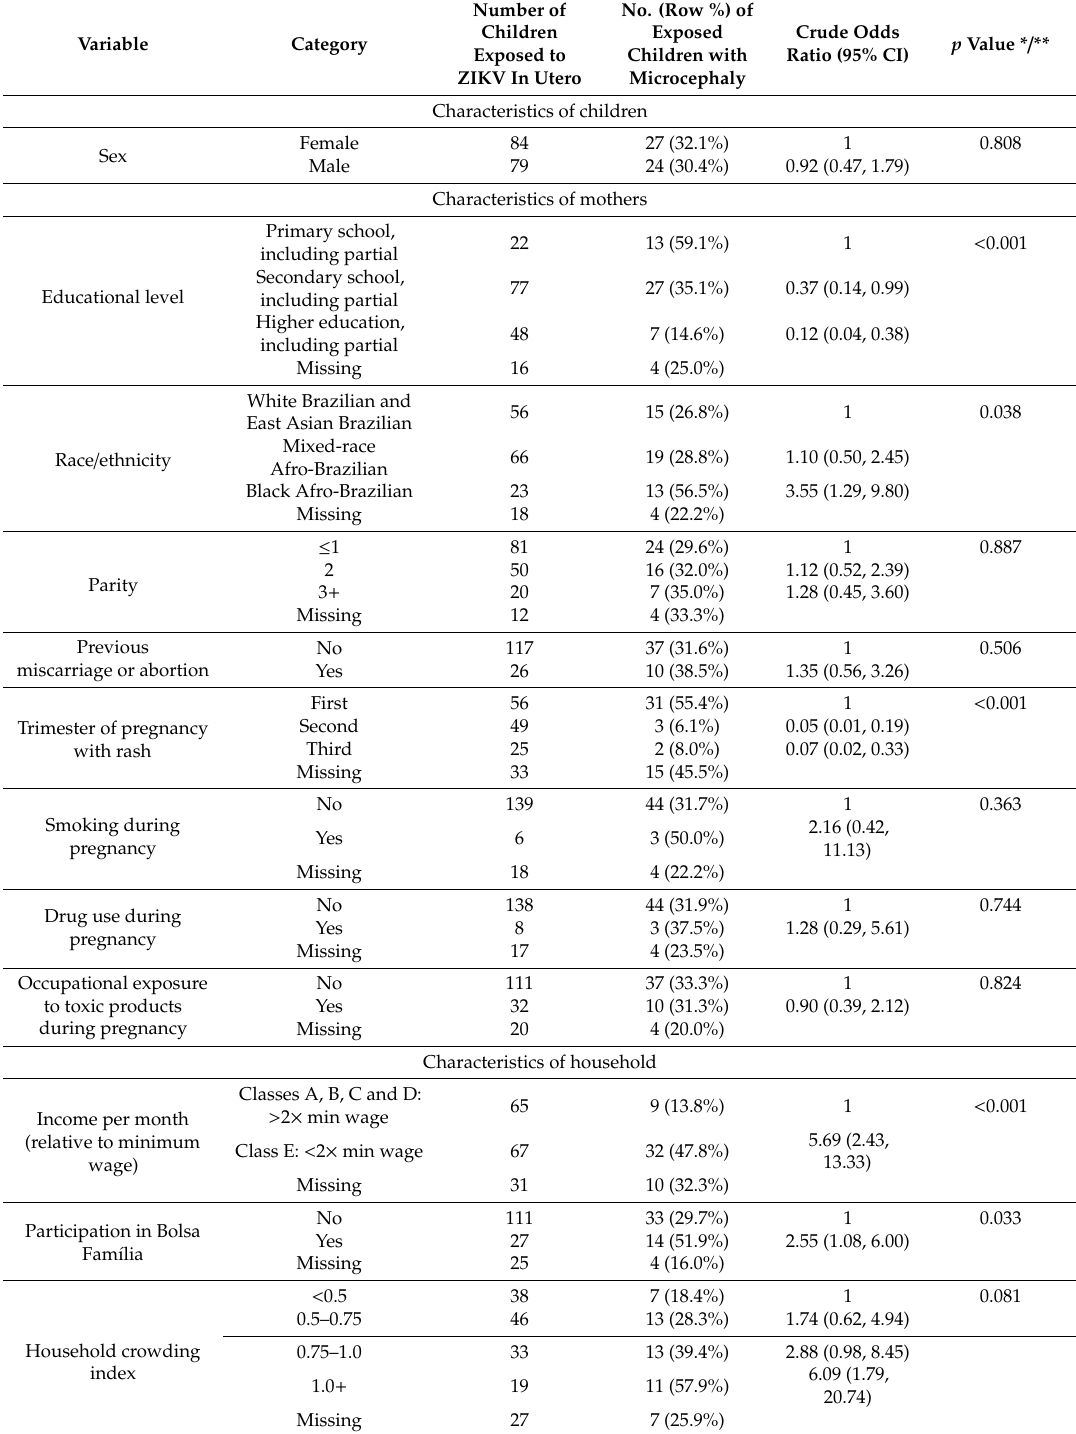
Table 2. Baseline distribution of child, maternal and household characteristics with crude odds ratios of microcephaly in children exposed to ZIKV in utero ( n =